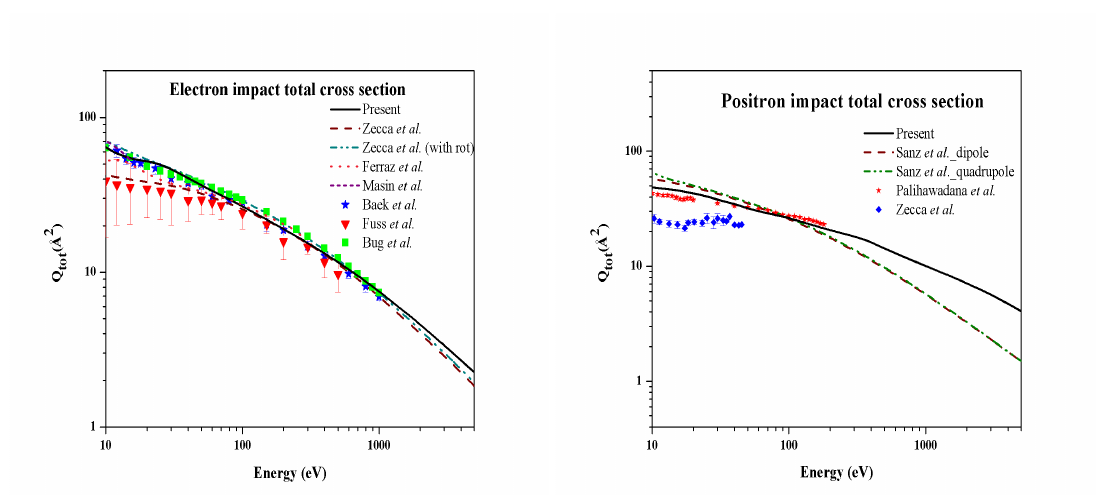
Figure 8. Left : Total cross section for e − -pyrimidine molecule interaction [222]. Right : Total cross section for e + -pyrimidine molecule interaction